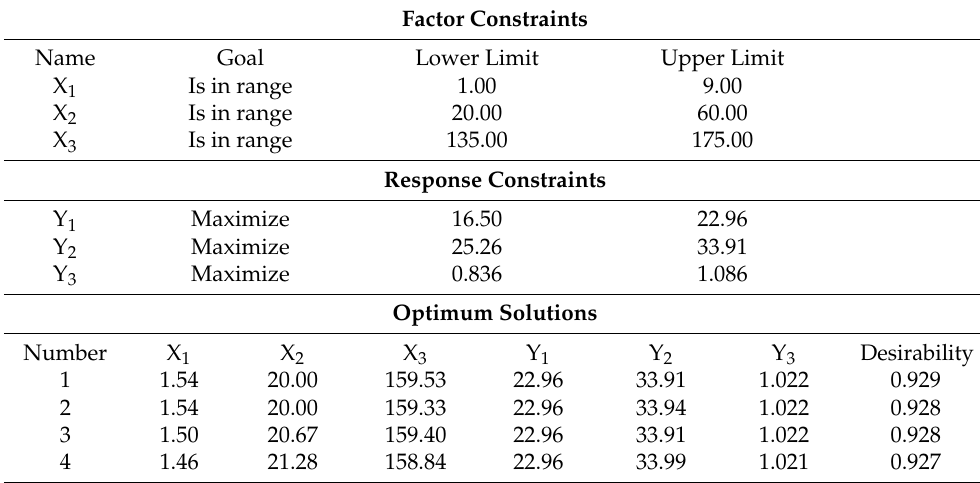
Table 4. The settings and solutions of the numerical optimization criterion.